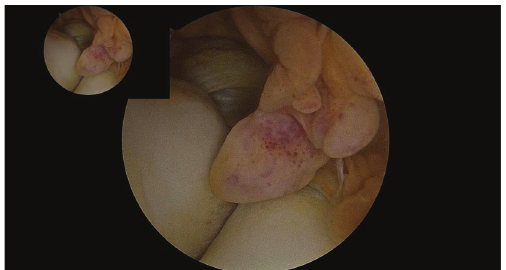
Figure 1: Arthroscopically view of PVNS of the